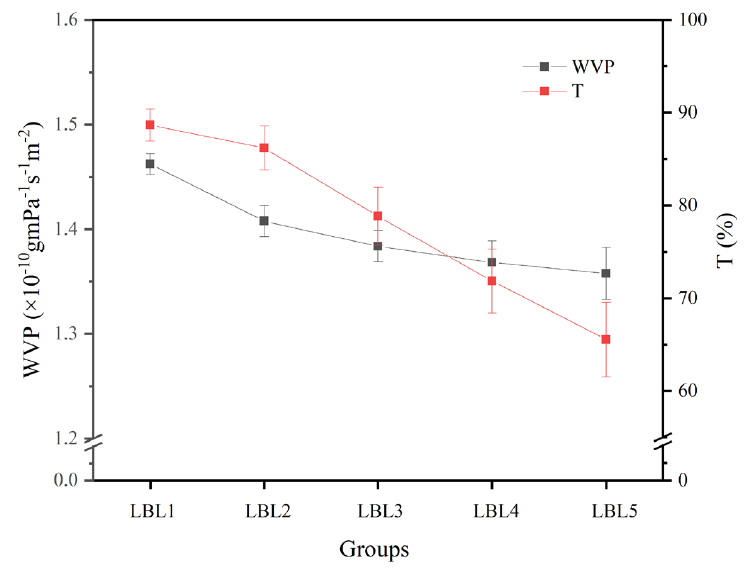
Figure 4. Effect of multilayer on water vapor permeability (WVP) and transmittance (T) of the films.